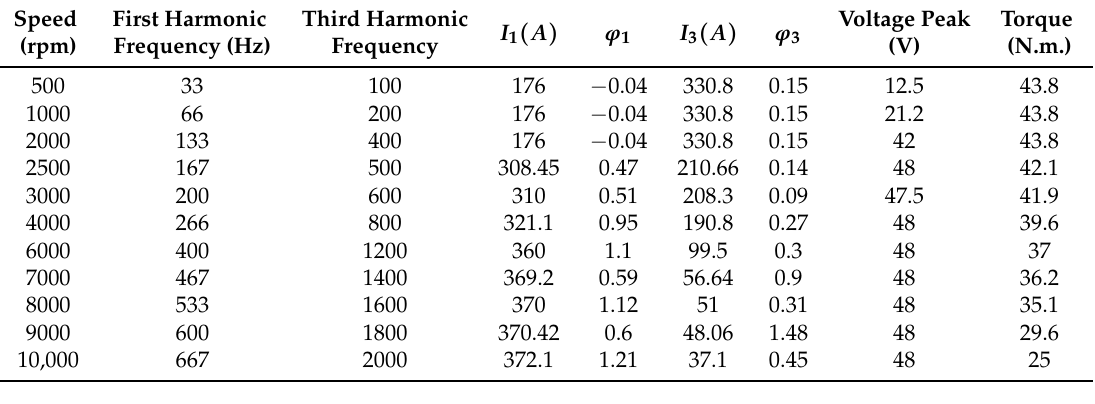
Table 2. Optimal currents for the MTPA strategy with J = 10 A/mm 2 .